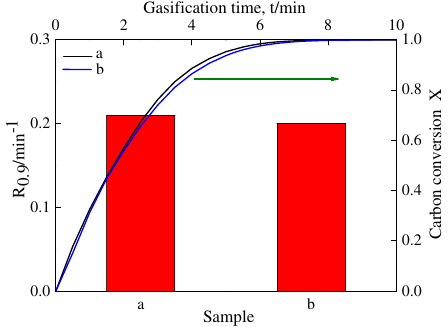
Fig. 3 IWC and analytical reagent Fe 2 O 3 catalyst on YCW gasifi- cation reactivity